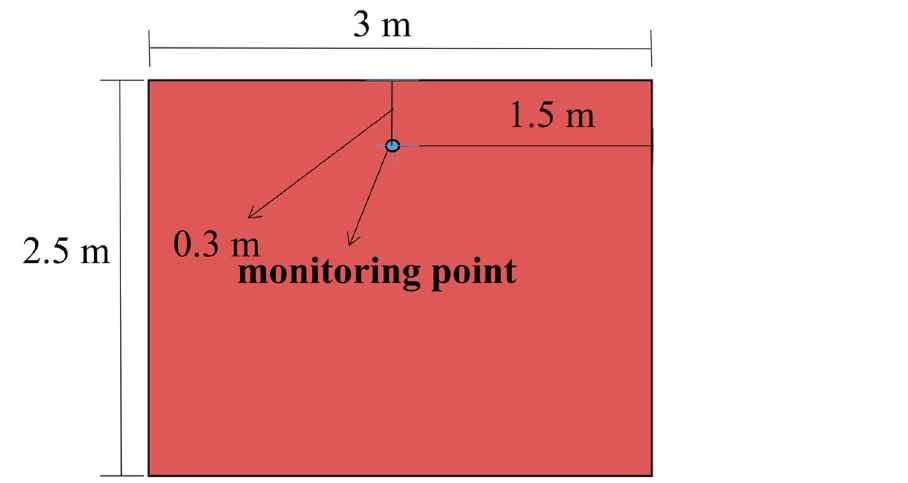
Fig 2. Cross section showing monitoring-point